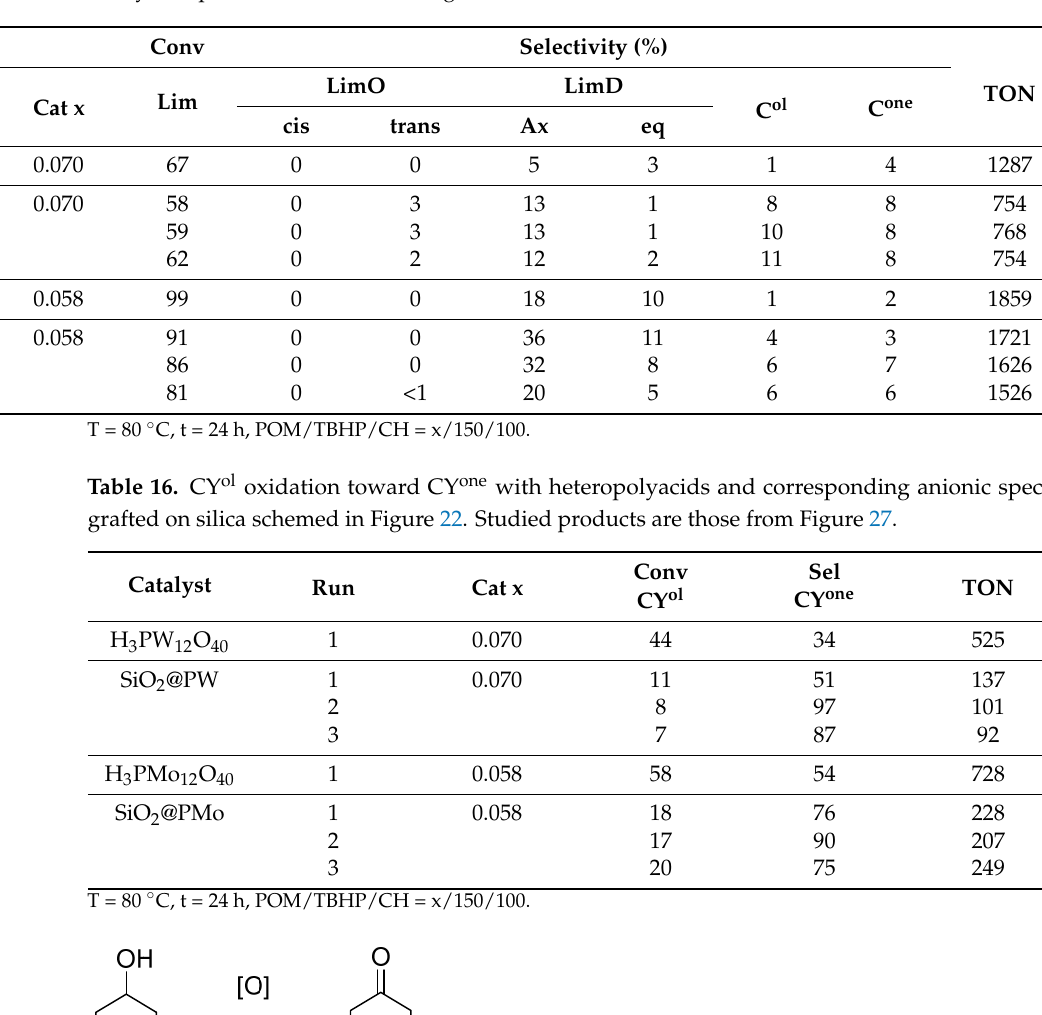
Table 15. Lim epoxidation with heteropolyacids and corresponding anionic species from Figure 24. Analyzed species can be found in Figures 16 and 18.